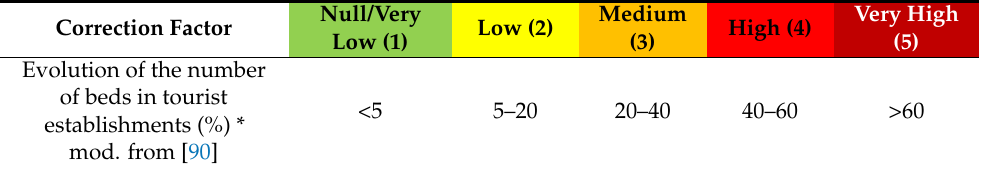
Table 9. Human Correction Factor: tourism trend at local